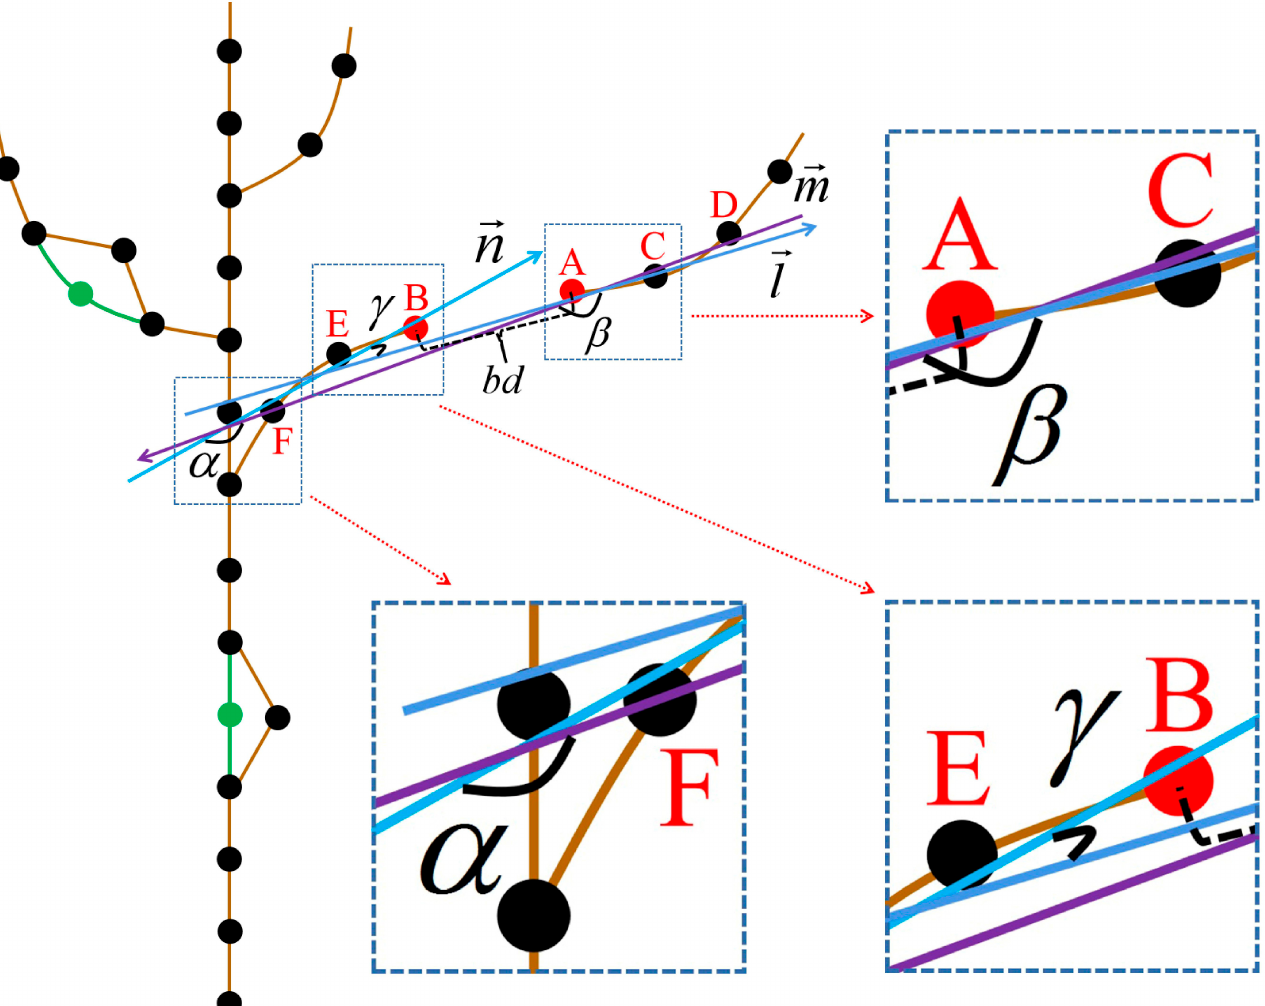
Figure 5. Schematic diagram of skeleton breakpoint connection. Black point: raw skeleton node; green point: skeleton node after smoothing; red point: breakpoint; purple line: line vector m → ; blue line: line vector n ; yellow line: line vector l .